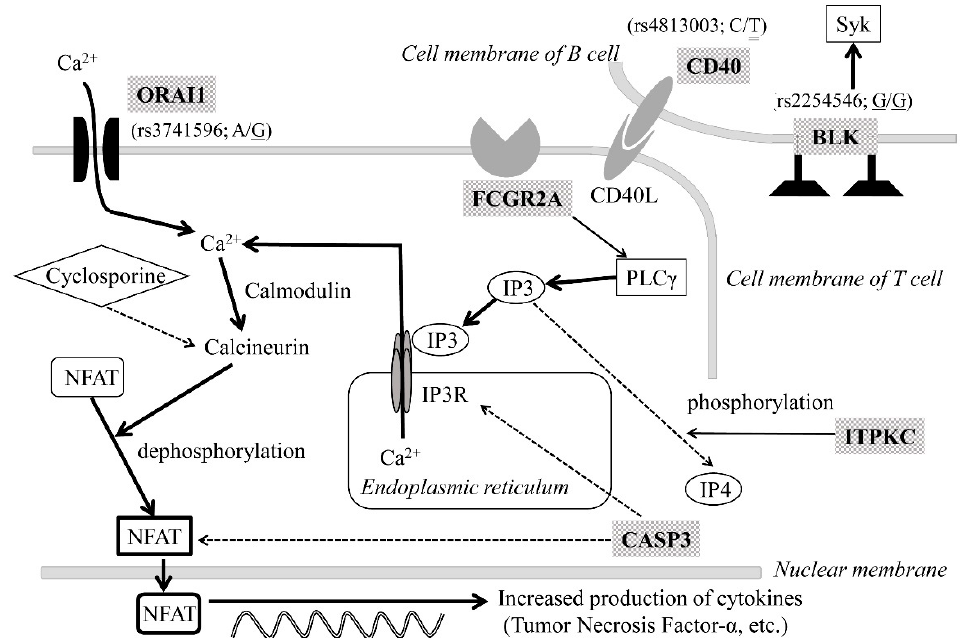
Figure 2. Susceptibility genes in Kawasaki disease in Japanese patients encoding molecules associated with T-cell activation. The present case had three significant single nucleotide variants (SNVs): ORAI1 (rs3741596), CD40 (rs4813003), or BLK (rs2254546). The types of SNVs, base substitutions, and genotypic patterns of the case are shown in parentheses. The single underline shows an alternative allele with risk for KD, and the double line means a neutral polymorphism. Shaded molecular names are encoded by the representative disease susceptibility genes in Japanese KD patients. Solid lines with arrows indicate activation, while dashed lines with arrows denote the suppression of the calcineurin/NFAT signaling pathway. Abbreviations: BLK, B lymphoid tyrosine kinase; CASP3, caspase-3; FCGR2A, Fc fragment of IgG low-affinity IIa receptor; He, heterozygous genotype; Ho, homozygous genotype; ITPKC, inositol